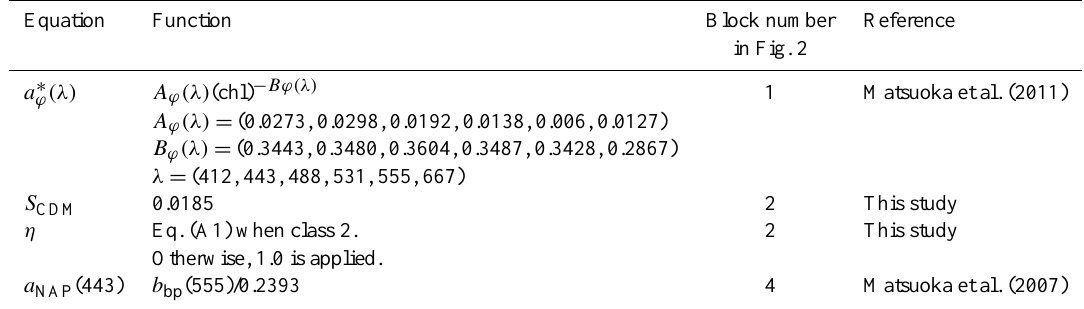
Table A1. Summary of the relationships used for developing our CDOM algorithm for Arctic waters. Equation Function Block number Reference